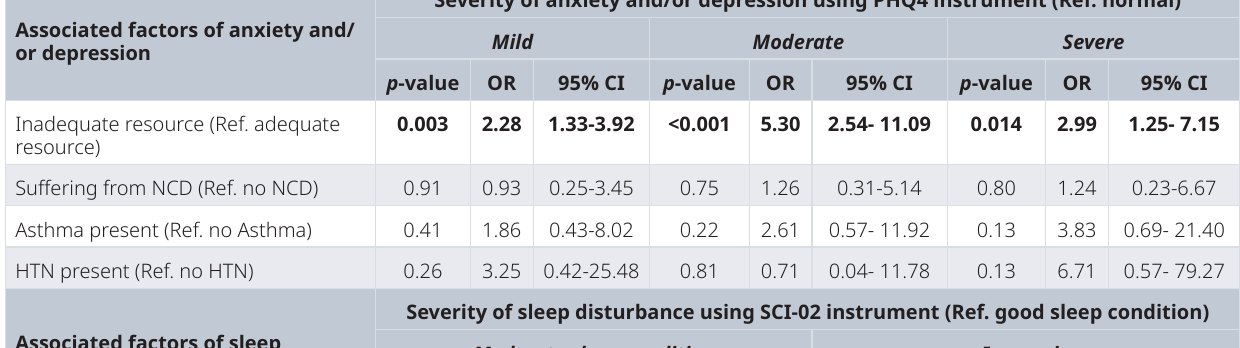
Table 5. Factors determining the psychological burden of the COVID-19 pandemic among frontline doctors of Bangladesh, using multinomial logistic regression analysis (n= 370). Severity of anxiety and/or depression using PHQ4 instrument (Ref. normal) Associated factors of anxiety and/ or depression